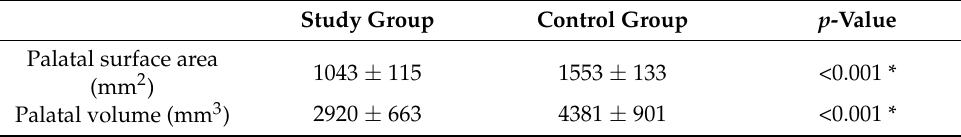
Table 4. Palatal surface area and palatal